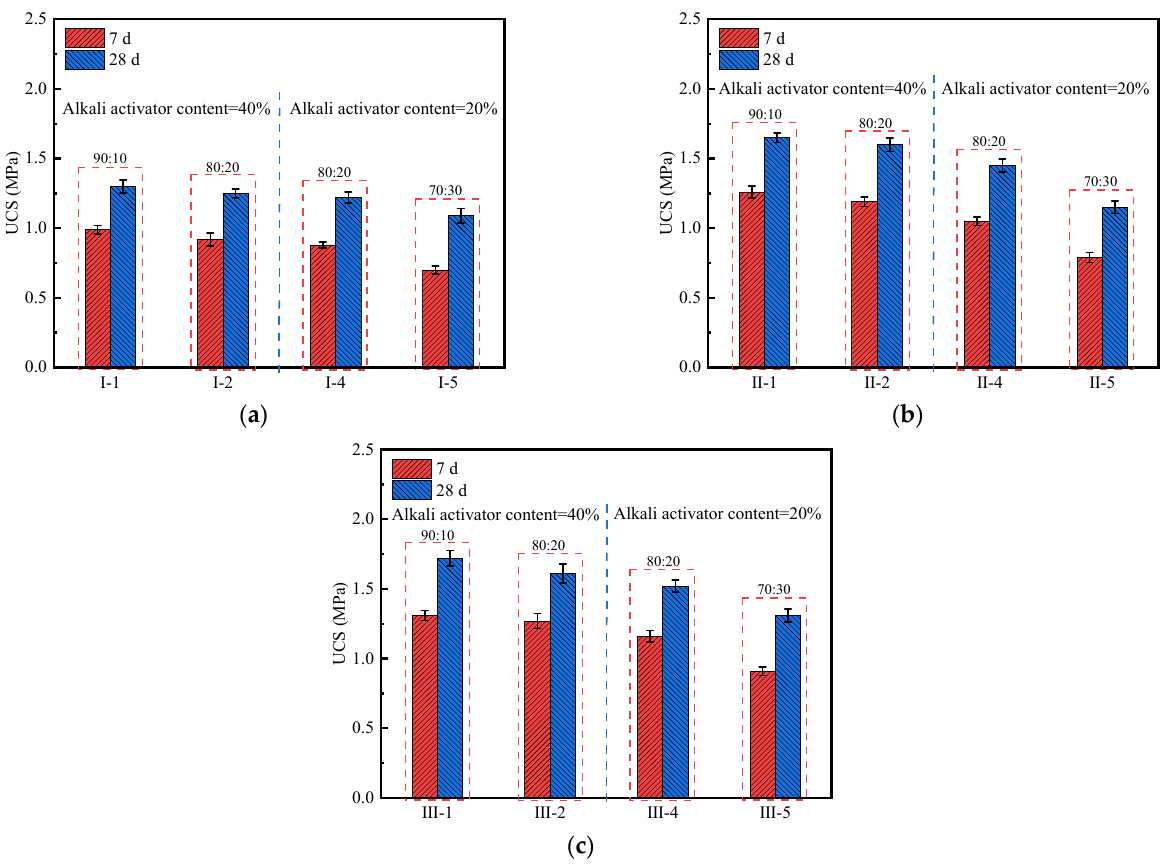
Figure 4. The UCS value of geopolymer stabilized soil with different slag–fly ash ratios (90:10, 80:20, and 70:30): ( a ) Geopolymer content = 12%; ( b ) Geopolymer content = 15%; ( c ) Geopolymer content = 18%.